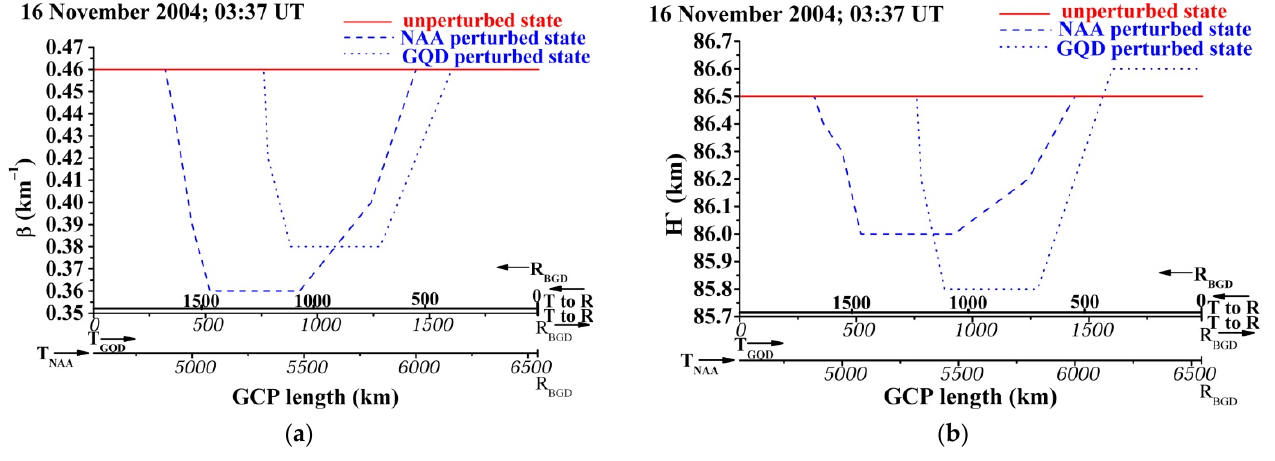
Figure 8. Parameter β and H ’ changing along GCP path towards the Belgrade receiver, for considered VLF signal waveguides (NAA in dashed lines and GQD in dotted lines), for unperturbed (red) and perturbed (blue) ionospheric states, on 16 November 2004 (R is for receiver, T is for transmitter, black arrows on x axis point the direction of view): ( a ) parameter β and ( b ) parameter H ’.